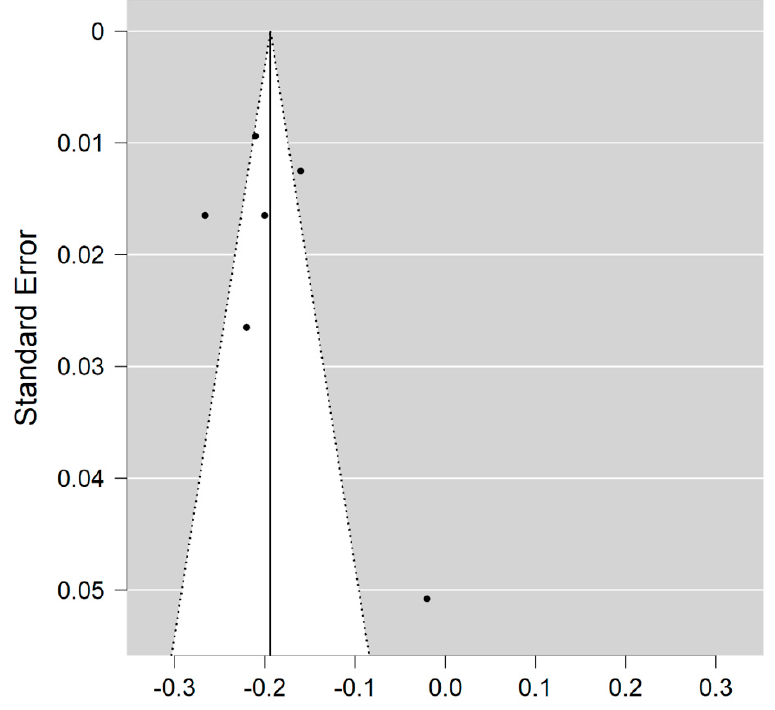
Figure 4. Forest plot for the standardized mean difference of the NDI in NAWM (MS vs. control) [20,23–27,29]. Abbreviations: SD = standard deviation; CI = confidence interval; NDI = Neurite Density Index; MS = multiple sclerosis; NAWM = normal-appearing white matter; vs. = versus; and I2 = Heterogeneity Index.